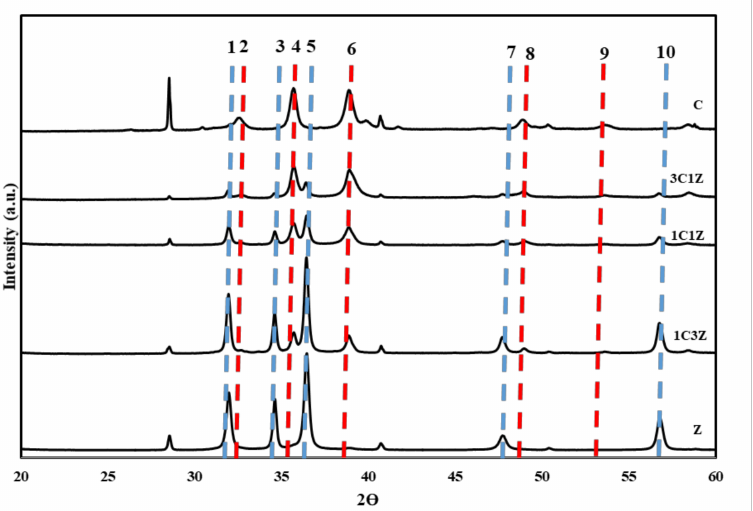
Figure 2. XRD patterns of Z, 1C3Z, 1C1Z, 3C1Z, and C greenly prepared via hydrothermal route (pH = 10, T = 250 ◦ C, t = 2.5 h) and calcination for 2 h at 300 ◦